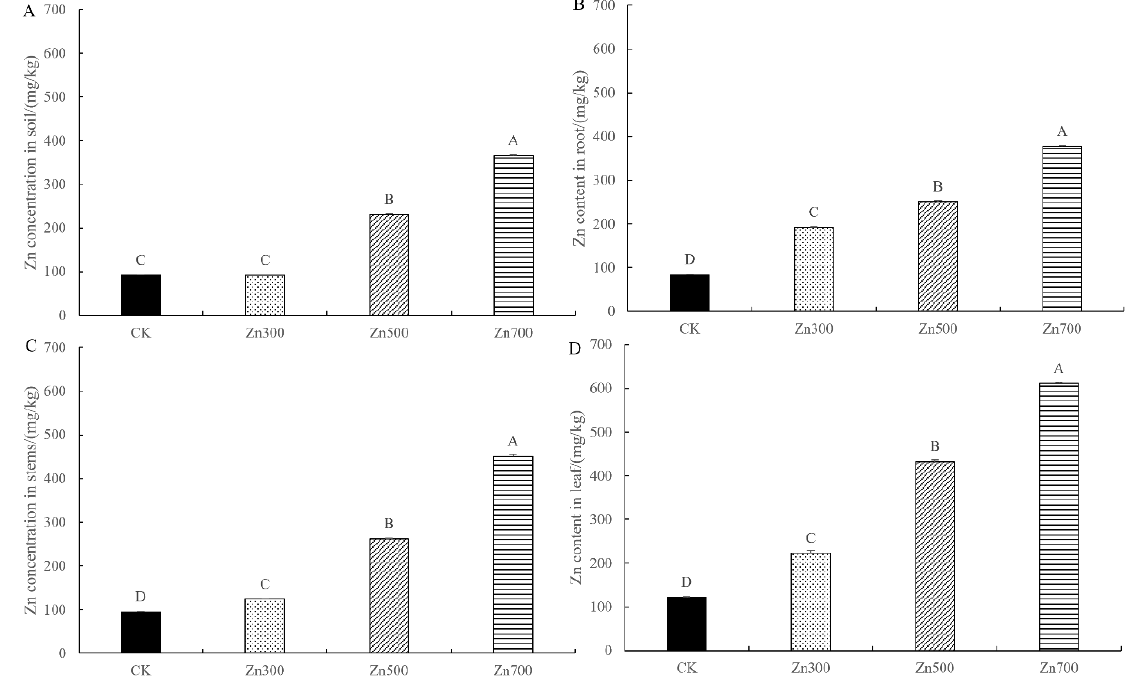
Figure 1. Zn enrichment in the soil ( A ), as well as the roots ( B ), stems ( C ), and leaves ( D ) of P. simonii . The values shown in the figure are the average value ± SD (n = 3). Different letters indicate that there are significant differences among groups (one-way ANOVA, p <